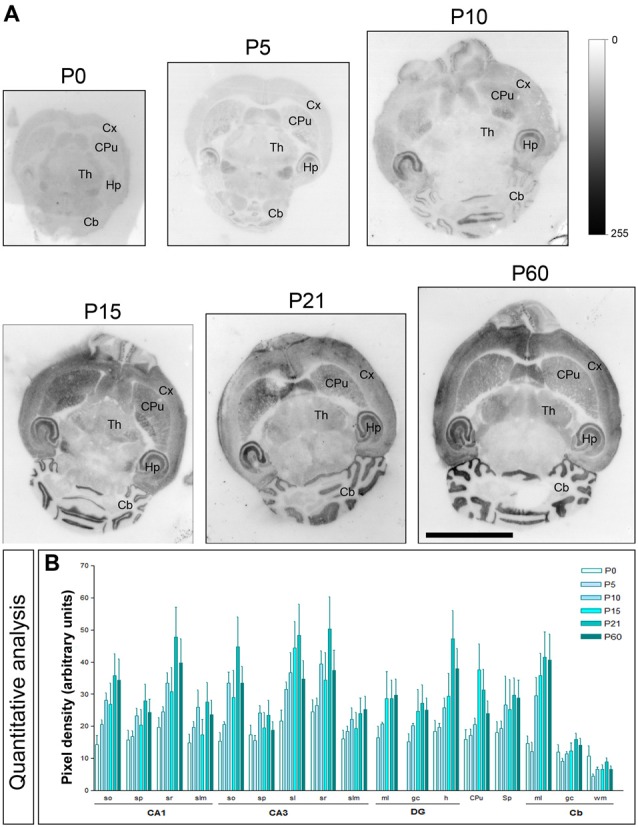
Developmental and regional distribution of the T-type Ca2+ channel Cav3.2 subtype in the mouse brain. (A) Cav3.2 protein distribution was visualized on histoblots of brain horizontal sections at various stages of postnatal development using an affinity-purified anti-Cav3.2 antibody. Cav3.2 was widely expressed in the brain since the day of birth (P0), and at all stages the strongest expression level was detected in the Hp, Cb and CPu. (B) The histoblots were scanned and densitometric measurements from four independent experiments were averaged to compare the protein densities for each developmental time point. This quantitative analysis shows a differential Cav3.2 expression in a developmental stage- and region-specific manner. The CPu and Cb Cav3.2 expression increase with age peaking at P21. In most subfields of the Hp and Sp, the expression increase until P10, decreased at P15 and increased again to peak at P21. so, stratum oriens; sp, stratum pyramidale; sr, stratum radiatum; slm, stratum lasunosum-moleculare; sl, stratum lucidum; ml, molecular layer; gc; granule cell layer; h, hilus; wm, white matter. CA1, CA1 region of the Hp; CA3, CA3 region of the Hp; DG, dentate gyrus. Error bars indicate SEM. Scale bar, 0.5 cm.